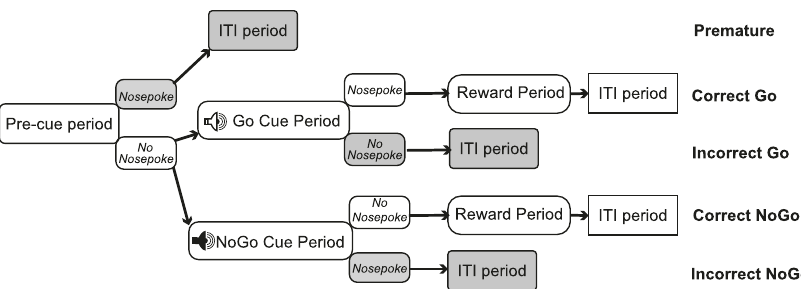
Fig. 5 Schematic of the Go/NoGo task. After a variable length Precue period (duration 9 – 24 s, cage light on), Go and NoGo periods (duration 10 s or until nosepoke, cage light on) are signaled to the animal via a distinct auditory cue. ITI stands for inter-trial interval (duration 10 s, cage light off). Premature responses during the Pre-cue period and incorrect responses during the Cue period trigger progression to the ITI, as does conclusion of the reward period (duration 3 s, cage light on). Shadowed boxes indicate